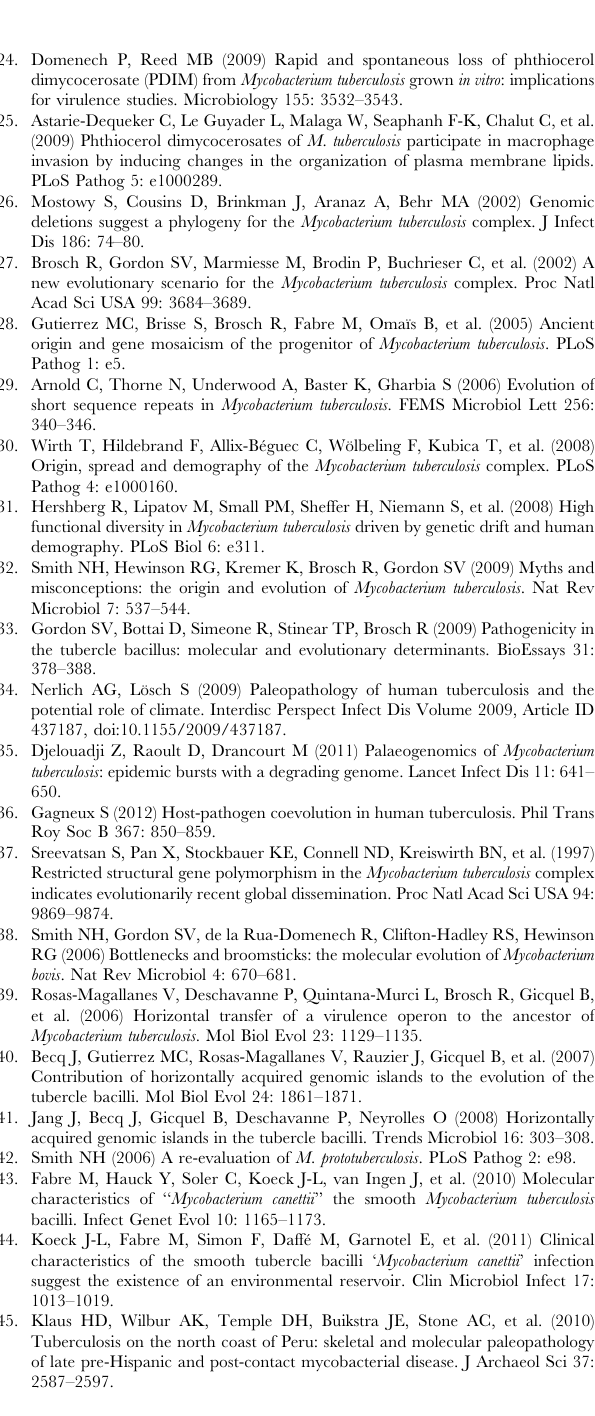
Figure S3 Solvent system for the purification of pyr- enebutyric acid (PBA) derivatives of members of the phthiocerol family on C 18 reverse phase cartridges. Figure S4 HPLC conditions for analysis of pyrenebu- tyric acid (PBA) derivatives of members of the phthio- cerol